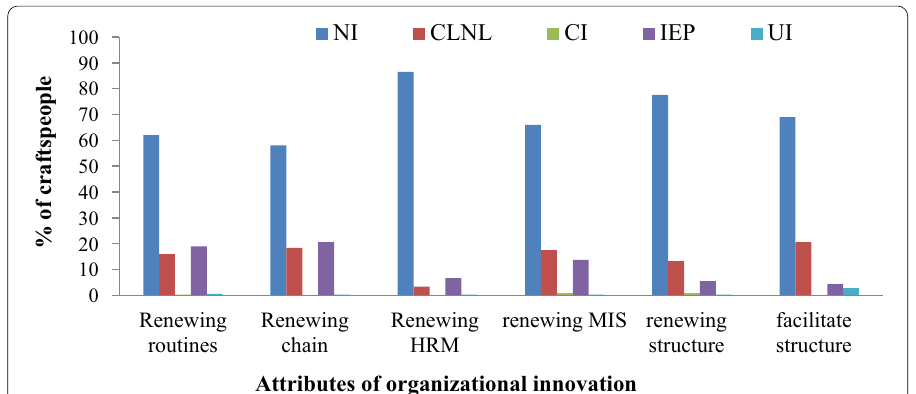
Fig. 7 Craftspeople implementation of organizational innovation. NI Not implemented, CLNL copied from local and national level, CI copied from international level, IEP improved from own experience and product, UI unique breakthrough innovation